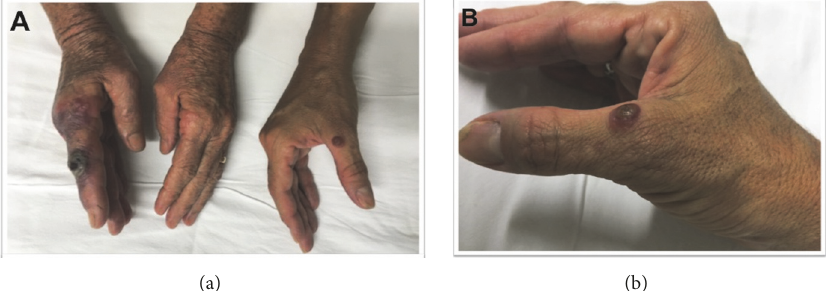
Figure 1: (a) Erythematous-violaceous papules and an ulcerated violaceous nodule on the patient’s (left) and her daughter’s (right) fingers;